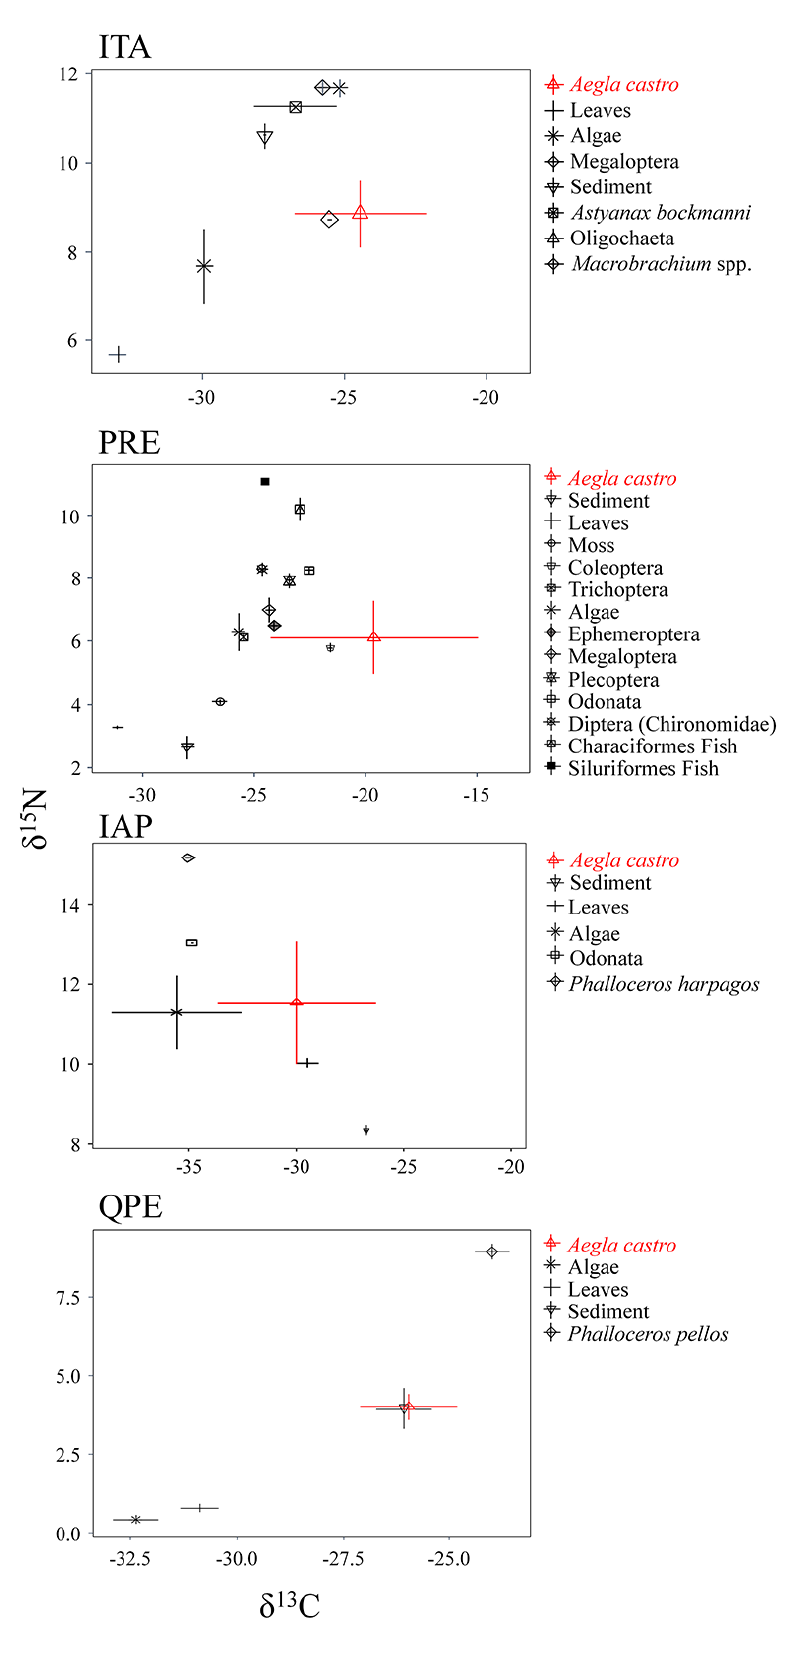
Figure 5. Biplots of stable isotopes using the mean for δ 13 C and δ 15 N (± SD). Calculated values for Aegla castro and potential food sources from ITA (Itaúna stream), PRE (Preto stream), IAP (Iapó stream), and QPE (Quebra Perna